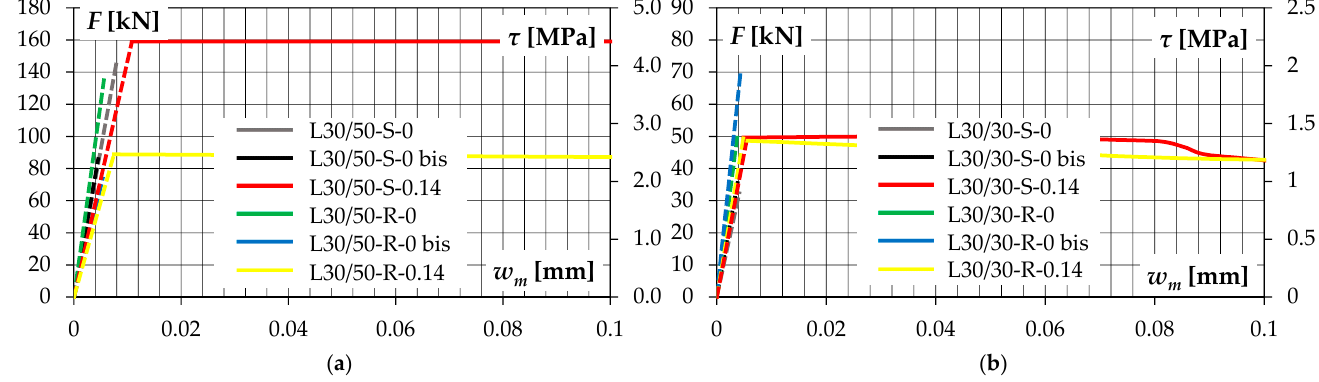
Figure 12. Applied force—crack width relationships for test specimens of: ( a ) L30/50 series, ( b ) L30/30 series. Table 8. Load carrying capacities and corresponding deformation characteristics.